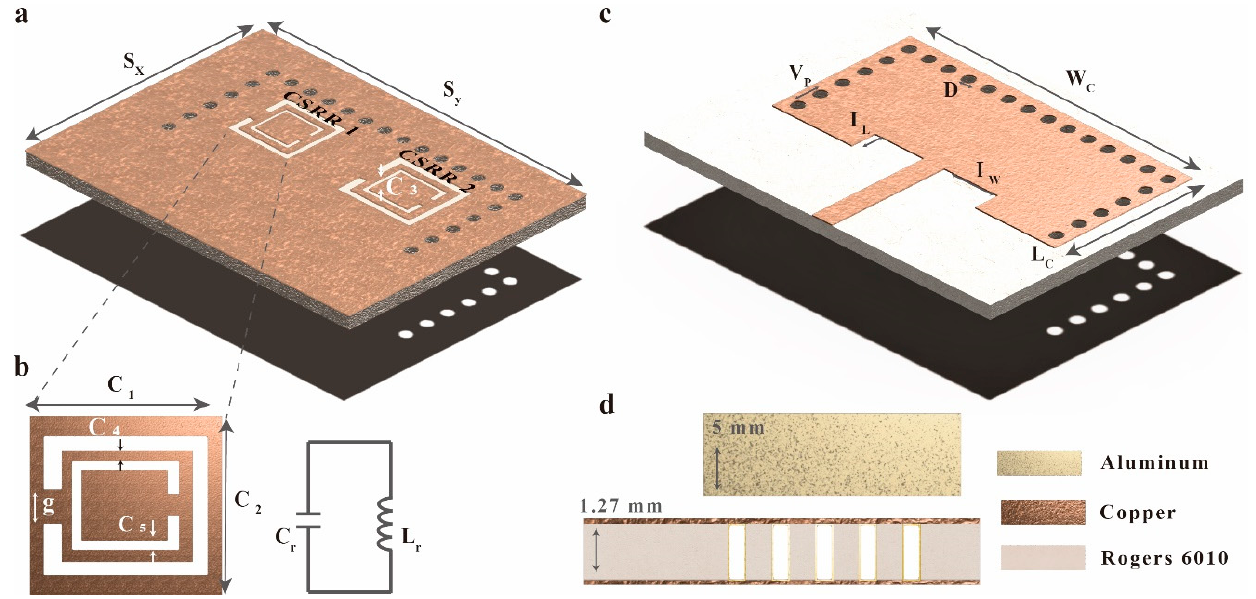
Figure 2. Proposed dual-crack detection sensor: ( a ) top view, ( b ) CSRR structure and equivalent circuit, ( c ) bottom view, and ( d ) side view.